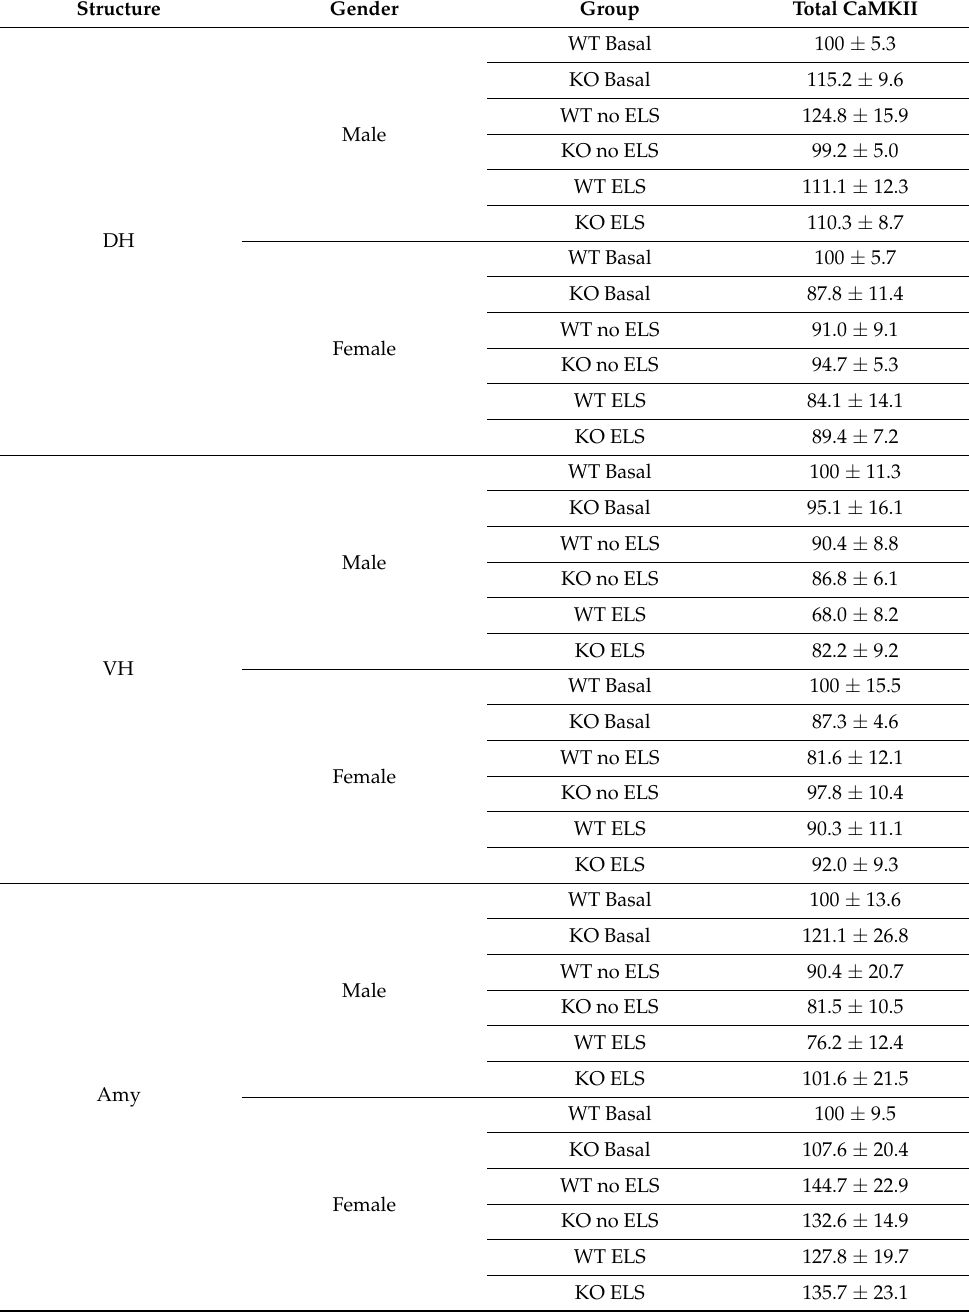
Table 1. Effect of early life stress in WT and GPR37KO mice on the expression of total CaMKII in the dorsal hippocampus (DH); WT basal male = 6, WT no-ELS male = 7, WT ELS male = 6, KO basal male = 7, KO no-ELS male = 7, KO ELS male = 6, WT basal female = 6, WT no-ELS female = 6, WT ELS female = 6, KO basal female = 6, KO no-ELS female = 6 and KO ELS female = 6; Ventral hippocampus (VH); WT basal male = 6, WT no-ELS male = 6, WT ELS male = 7, KO basal male = 7, KO no-ELS male = 7, KO ELS male = 6, WT basal female = 6, WT no-ELS female = 6, WT ELS female = 5, KO basal female = 6, KO no-ELS female = 6 and KO ELS female = 6; and Amygdala (Amy); WT basal male = 6, WT no-ELS male = 7, WT ELS male = 6, KO basal male = 7, KO no-ELS male = 6, KO ELS male = 5, WT basal female = 7, WT no-ELS female = 7, WT ELS female = 5, KO basal female = 6, KO no-ELS female = 8 and KO ELS female = 5. All data represent mean ± SEM. Structure Gender Group Total CaMKII WT